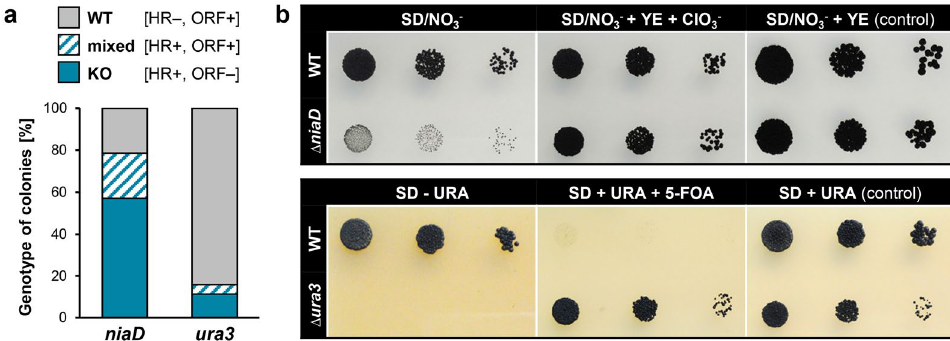
Figure 3. Traditional replacement approaches give very different outcomes. ( a ) Rates of homologous recombination (HR) vary between niaD and ura3 loci. Genes encoding the nitrate reductase NIAD (essential for nitrate assimilation) and the orotidine 5 ′ -phosphate decarboxylase URA3 (essential for uracil synthesis) were replaced by resistance cassettes in WT:A95 as specified in Fig. S4. 28 hygR transformants for niaD (from two independent experiments) and 44 natR transformants for ura3 (from three independent experiments)